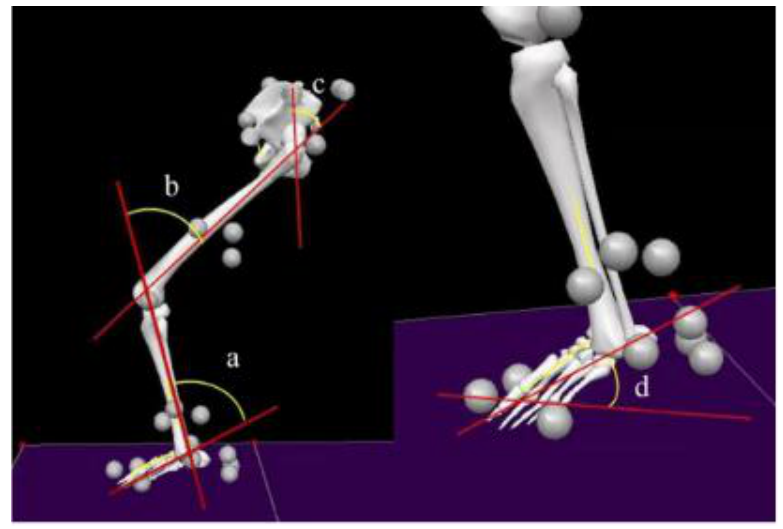
Figure 3. Placements on the pelvis, thigh, leg, forefoot, and rearfoot; along with the ( a ) ankle; ( b ) knee; ( c ) hip; and ( d ) metatarsophalangeal (MTP) joint angle